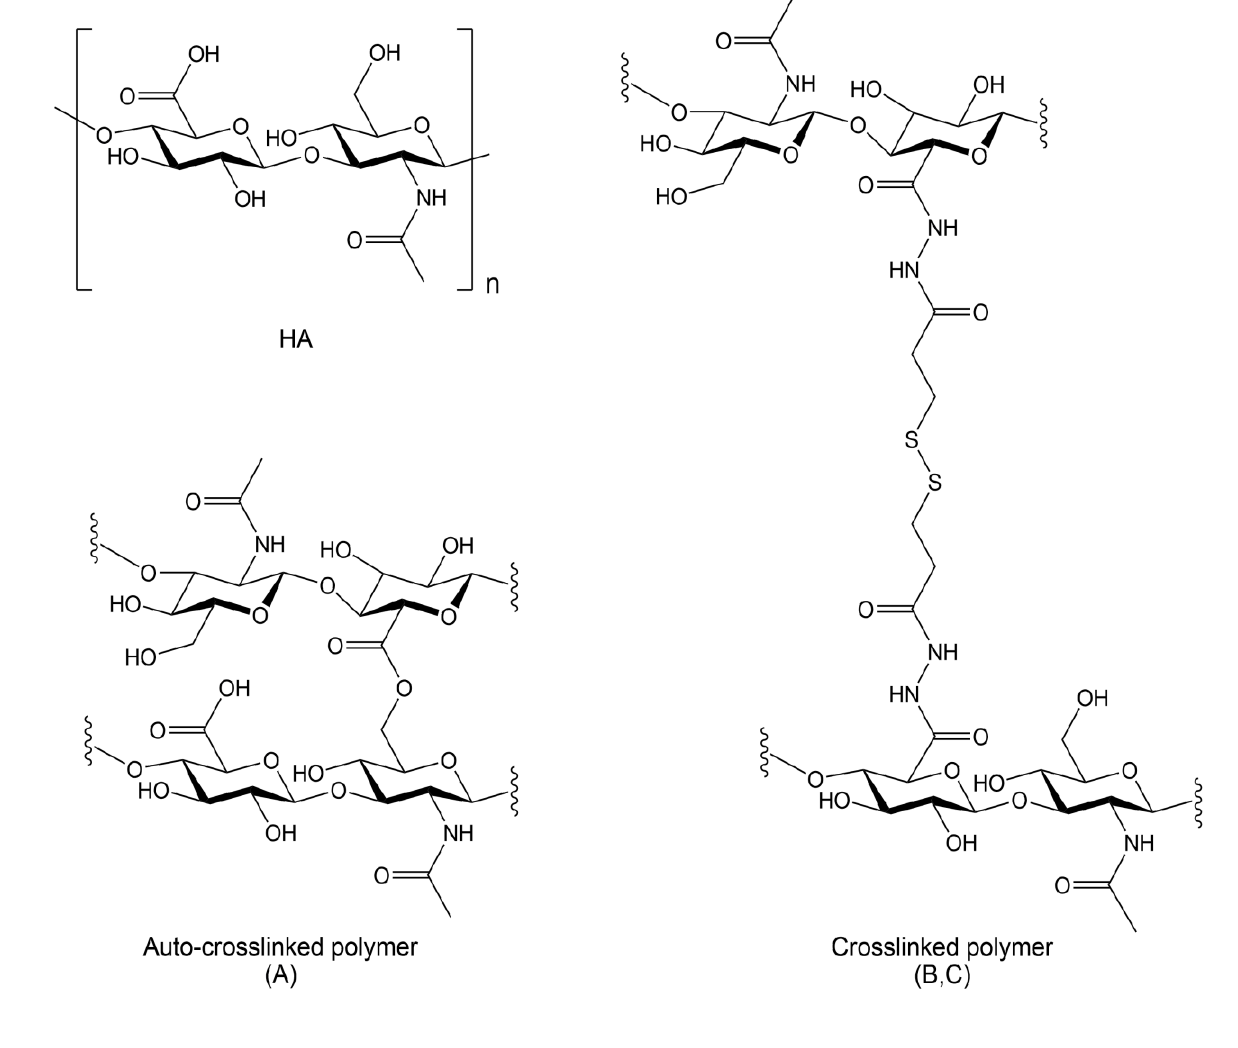
Figure 1. Chemical structure of hyaluronic acid-based polymers.